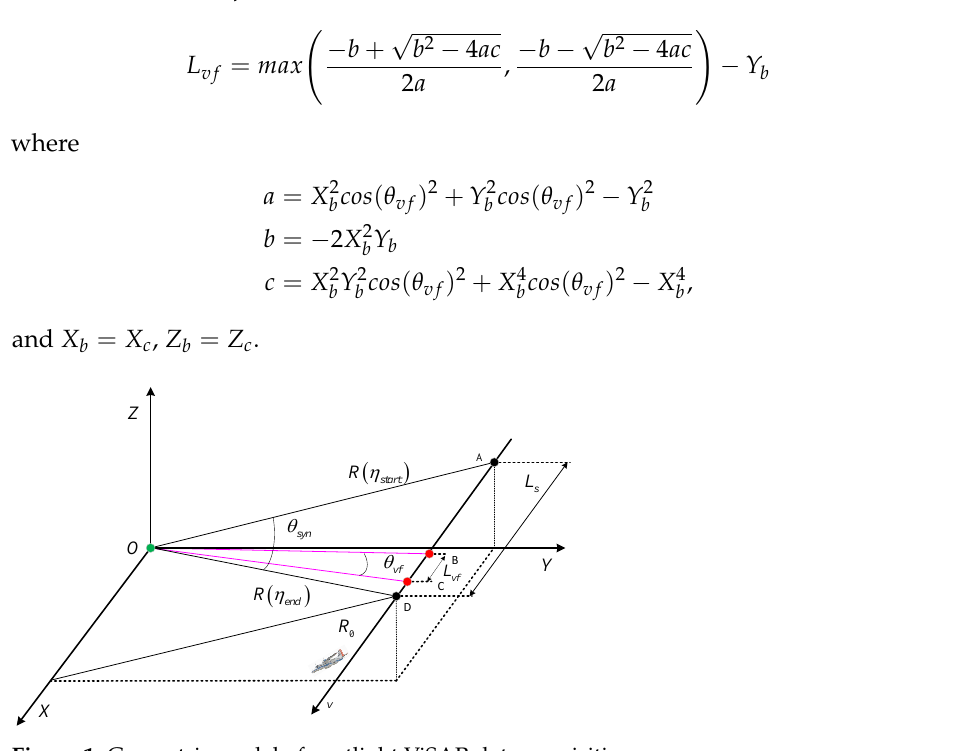
Figure 1. Geometric model of spotlight ViSAR data